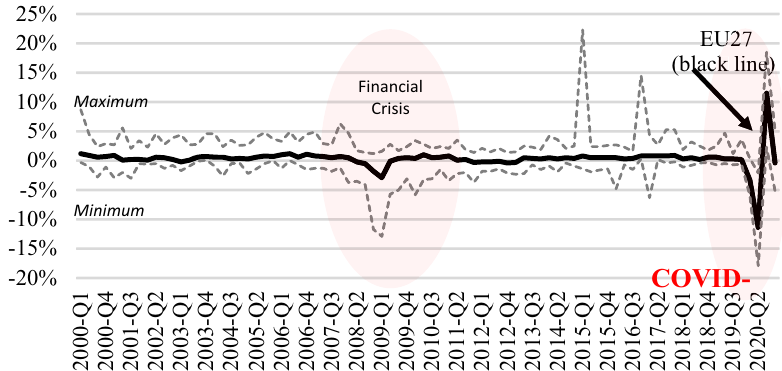
Figure 1: GDP evolution ( % change in previous period ) by quarter ( 2000 – 2020 ) . Source: Authors ’ elaboration based on data from Eurostat. Legend: Maximum – maximum value recorded within EU countries. Minimum – minimum value recorded within EU countries. EU 27 – average at EU 27